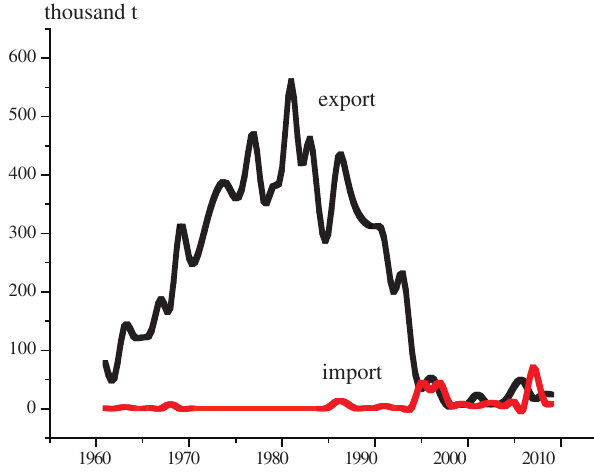
Fig. 1. The Hungarian apple export and import